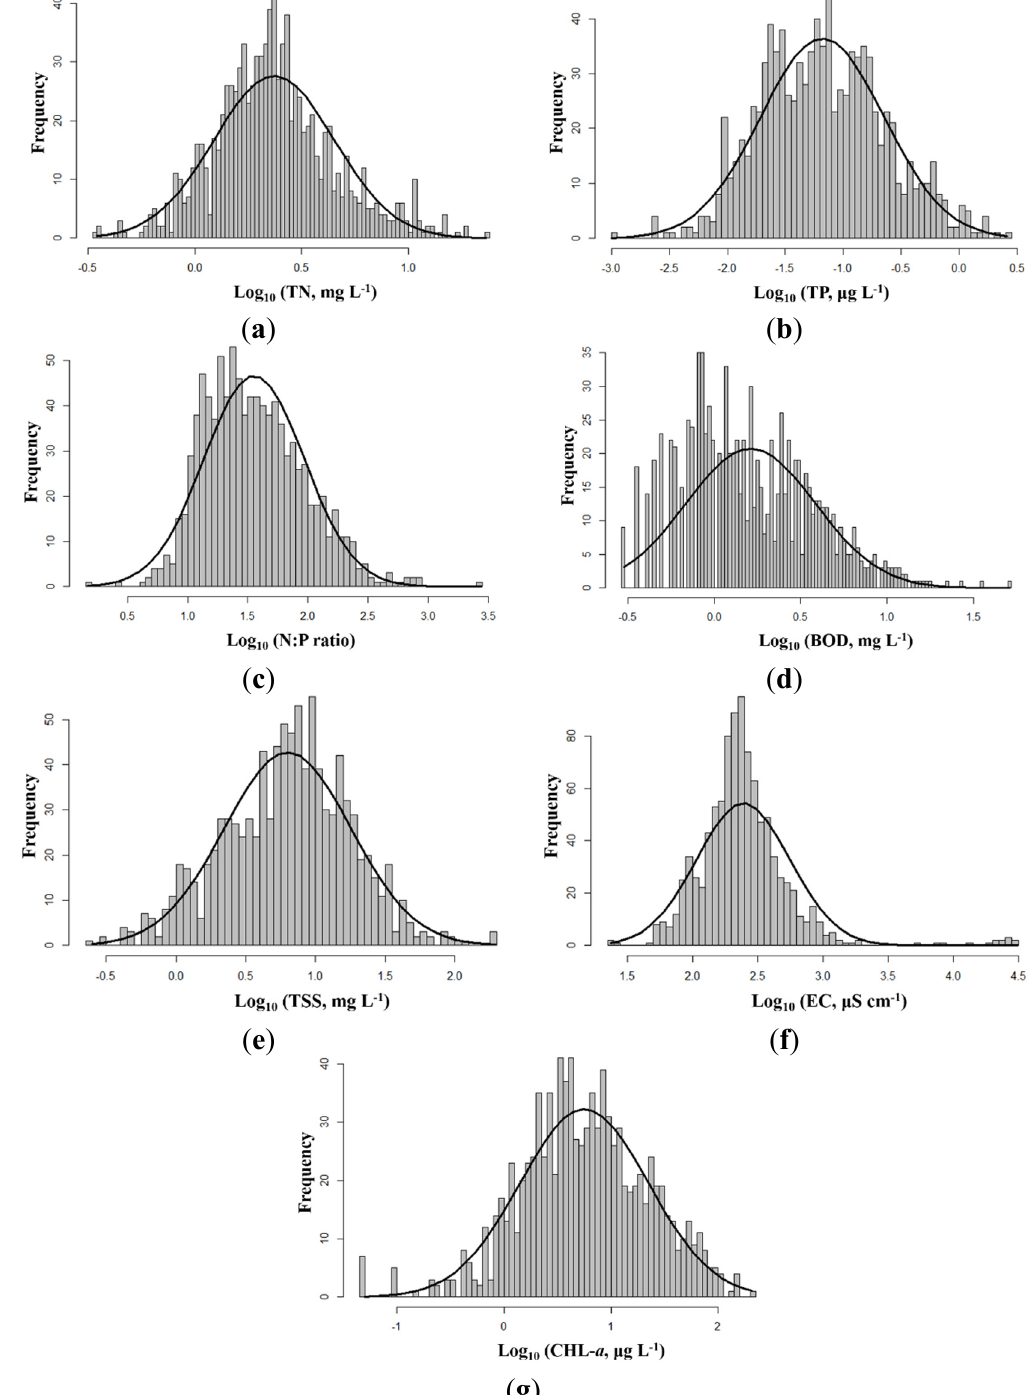
Figure 4. Observed frequency diagram (total nitrogen: n = 974, total phosphorus: n = 973, TN:TP ratio: n = 973, BOD: n = 974, total suspended solids: n = 974, electrical conductivity: n = 974, chlorophyll-a: n = 969). ( a ) M Total Phosphorus ( μ g·L − 1 ); ( c ) M Suspended Solids (mg·L − 1 ); ( f ) M Chlorophyll- a ( μ g·L − 1